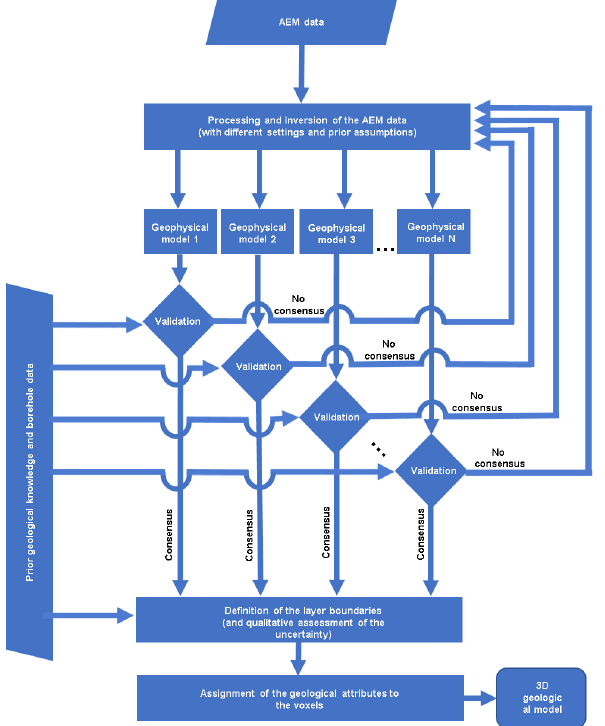
Figure 3. The workflow describing the iterative interaction between geologists and geophysicists leading to the development of the 3D geological model consistently integrating all the diverse pieces of information available (geophysical data, prior geological knowl- edge, wells,